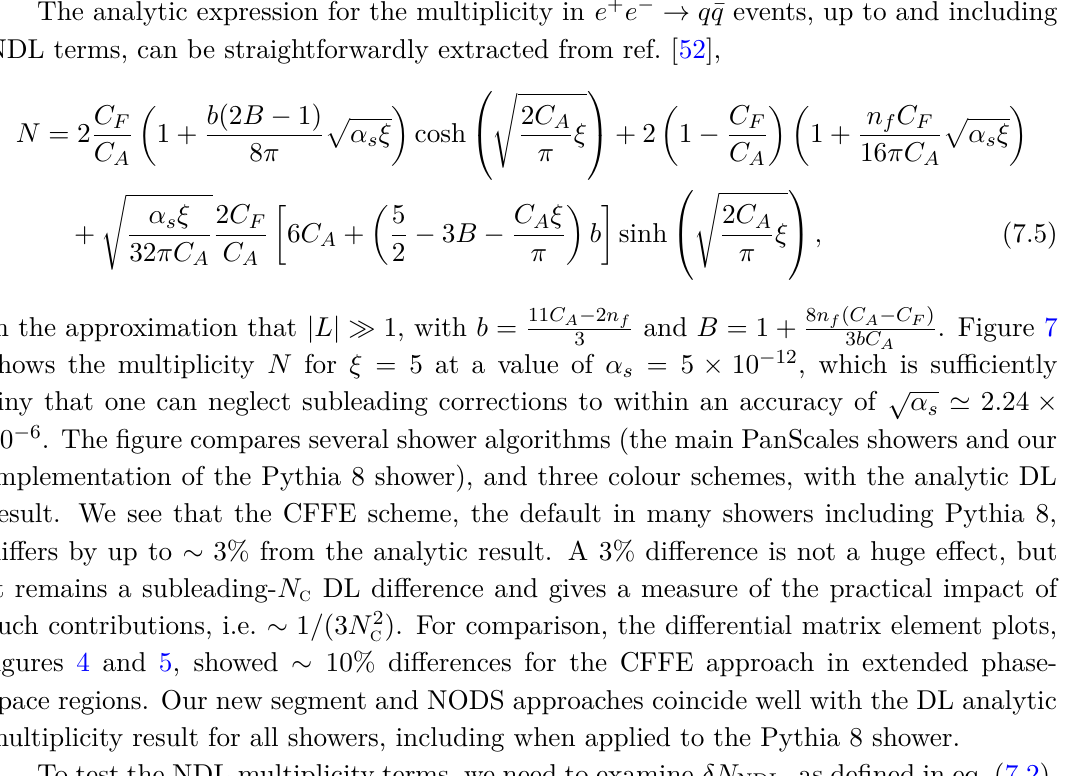
that NDL terms s 10 . 9008 DL ’